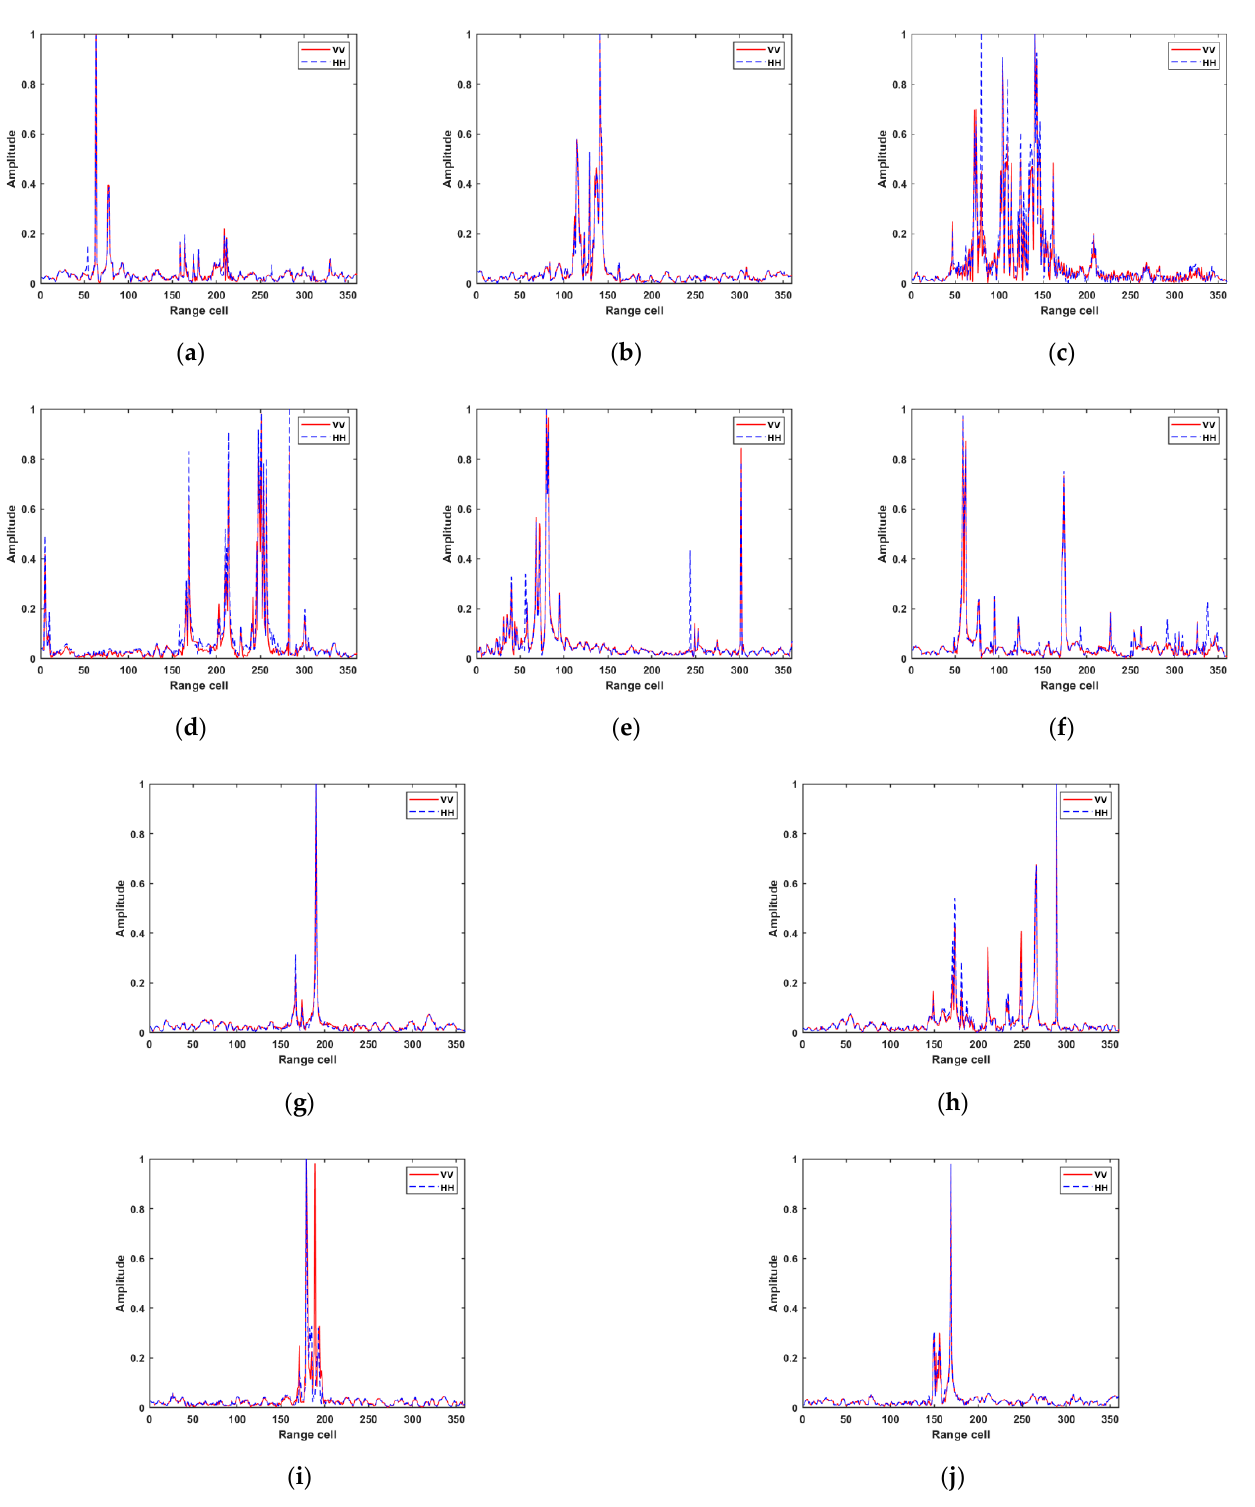
Figure 4. HRRP of class ten ship targets. ( a – j ) represent ships one–ten. The model parameters are set: the total number of training epochs is 300, the initial learning rate is 0.03, and the learning rate becomes one-fourth of the original one for every 80 iterations during the training process. The dimensions of the hidden layers are all set to 128. The optimizer is chosen to be Stochastic Gradient Descent (SGD) with a batch size of 32. The sliding window length of the preprocessing is d = 48 and the sliding distance l